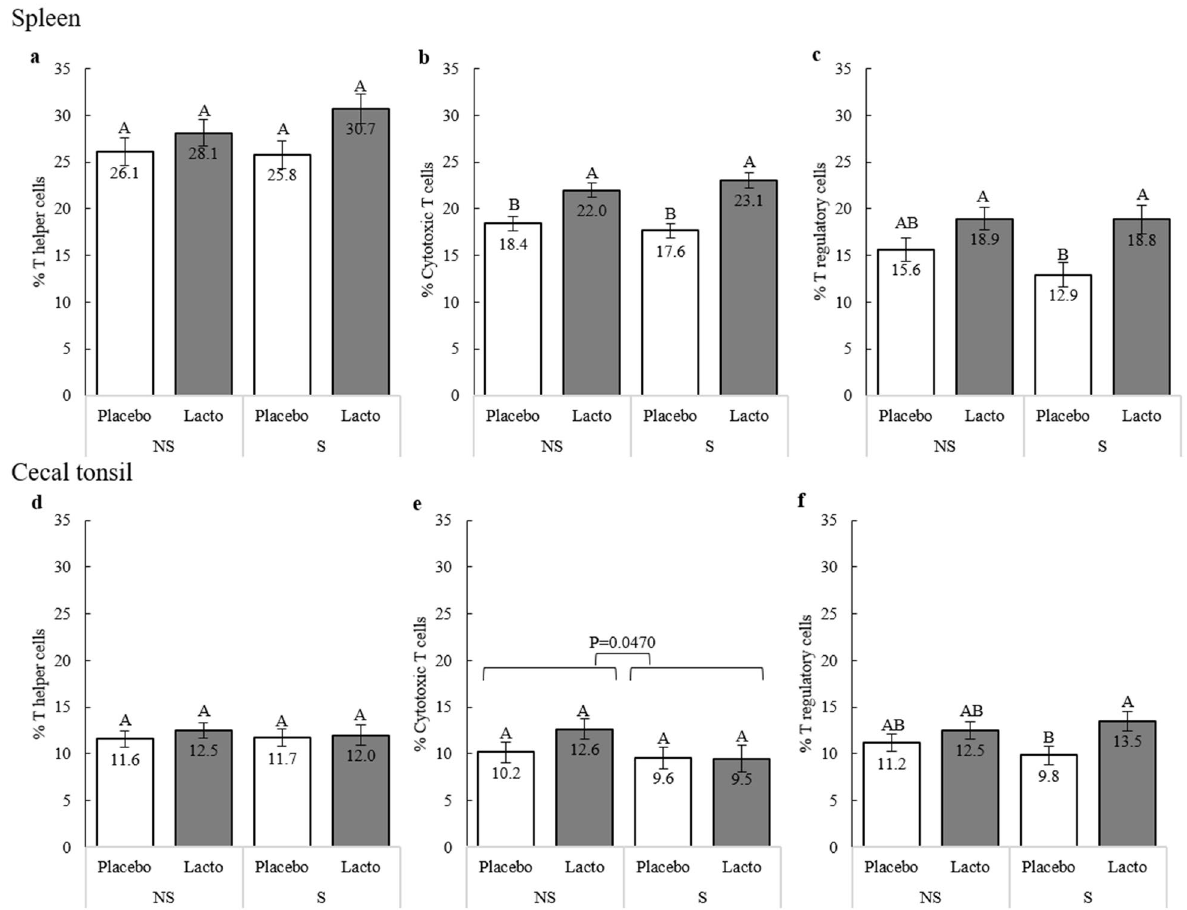
Figure 1. The T cell sub-populations in the spleen and cecal tonsils. Proportions of T cell subpopulations in the spleen ( a – c ) and cecal tonsil ( d – f ) after nine weeks of supplementation (0–9 weeks of age) and stress treatment (11–13 weeks of age). Sub-populations were identified using the following combinations of cell surface markers: T helper cells = CD3 + CD4 + ; cytotoxic T cells = CD3 + CD8 + ; T regulatory cells = CD4 + CD25 + (n of birds: S-Placebo = 9, NS-Placebo = 9, S-Lacto = 9, NS-Lacto = 9, whereby Lacto = L. rhamnosus, Placebo = water supplementation, S = stressed and NS = non-stressed) in 15 weeks old birds. Different letters indicate statistically significant differences within the Supplementation*Stress interaction (P <